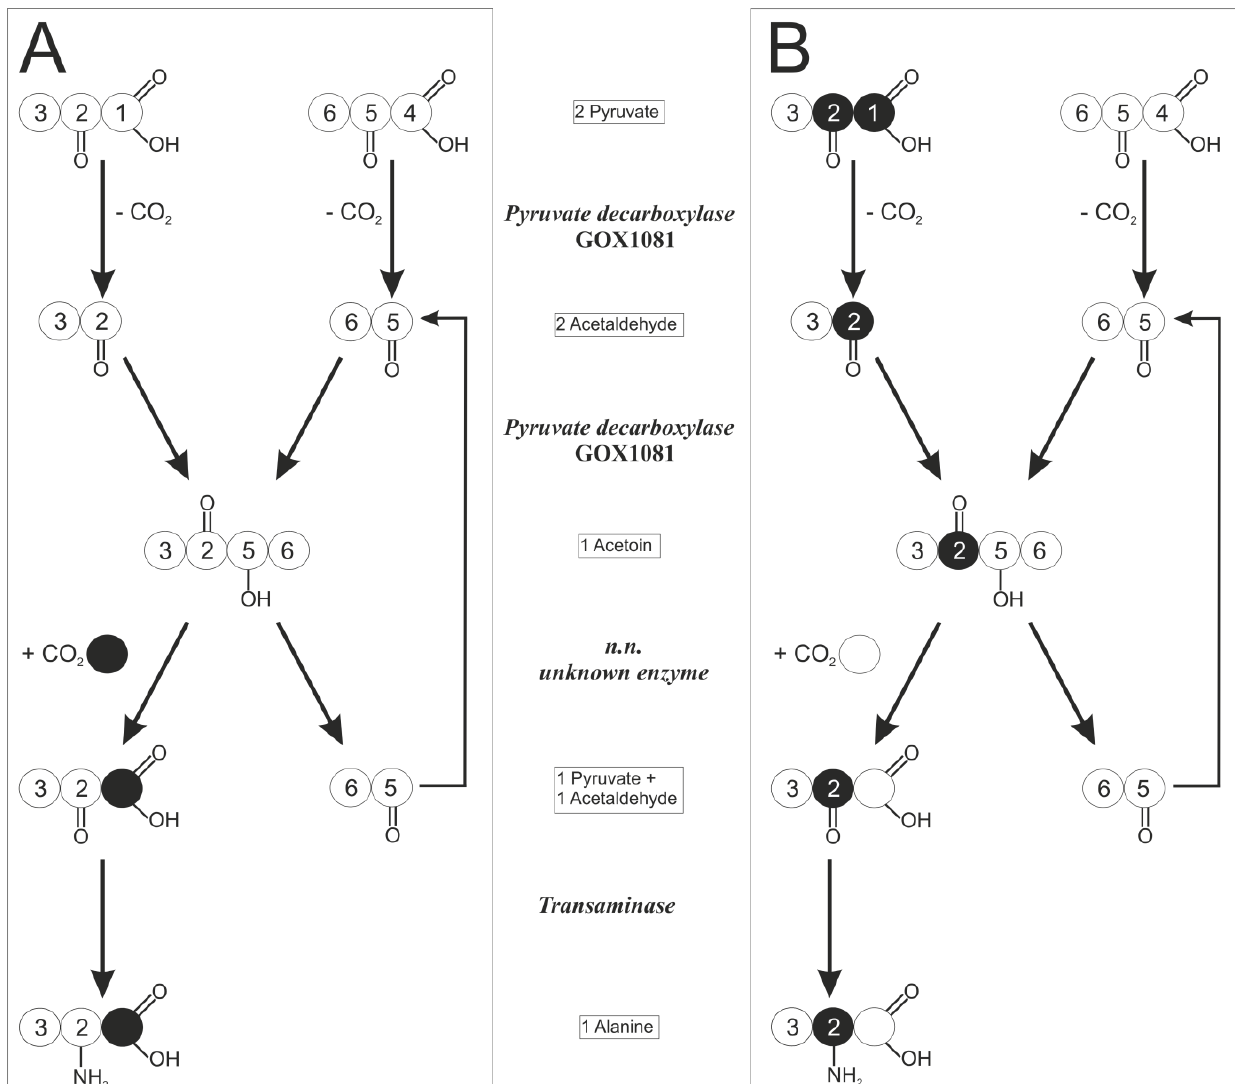
Figure 5. Scheme of a hypothetical reaction sequence from pyruvate via acetoin back to pyruvate, including the carbon transition. Atoms are labeled 13 C (black) or 12 C (white). The numbers originate from carbon position in the substrate glucose: ( A ) unlabeled precursors and 13 C-labeled CO 2 transformed to alanine generating m.1.0 signal; ( B ) double-labeled pyruvate originated from [1,2- 13 C]-labeled glucose transformed to alanine, generating an m.1.1